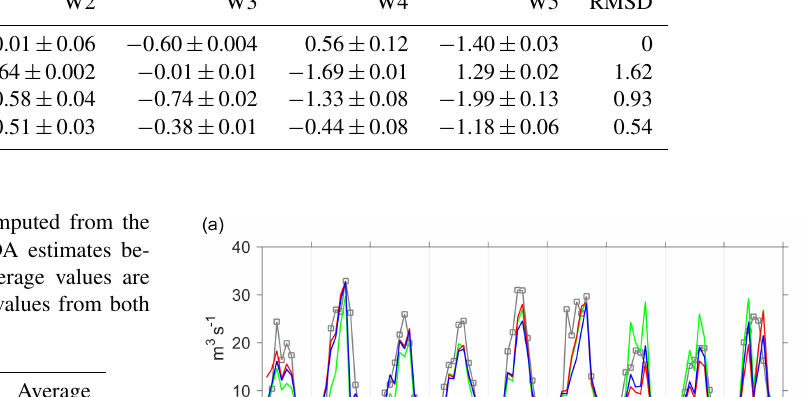
Table 5. Long-term trends and standard deviations of the in situ data and the DA estimates. The RMSDs between the in situ data and the DA trend estimates are also provided. W1 W2 W3 W4